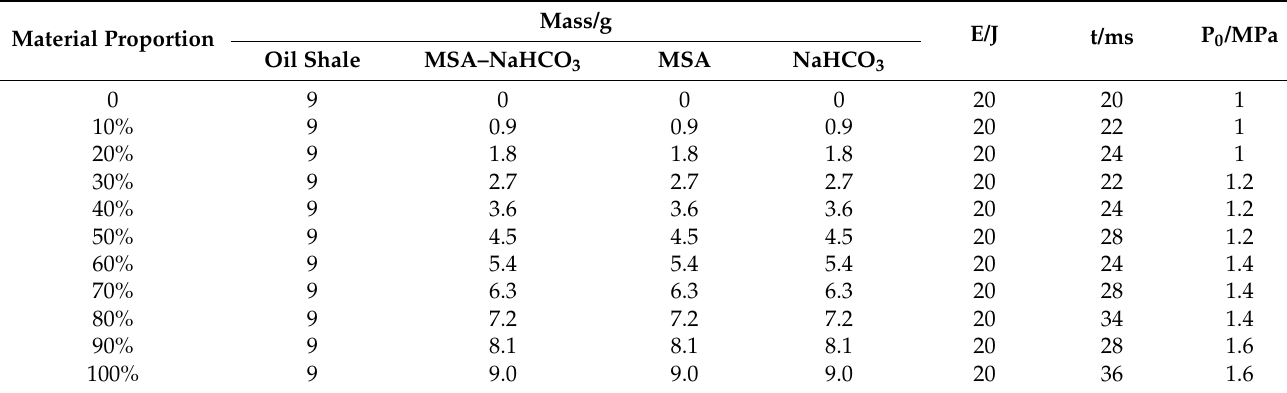
Table 5. Material proportion of mixed